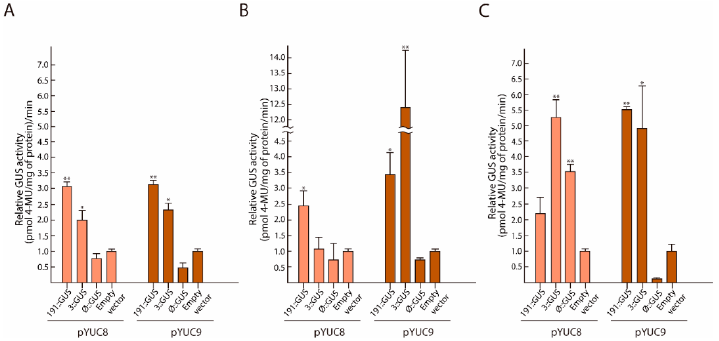
Figure A1. Genome browser screenshots showing the binding of MYC2 and MYC3 to the promoter regions of the eleven YUCCA genes. The figure shows the genomic regions around ( A ) YUC1 , At4g32540; ( B ) YUC2 , At4g13260; ( C ) YUC3 , At1g04610; ( D ) YUC4 , At5g11320; ( E ) YUC5 , At5g43890; ( F ) YUC6 , At5g25620; ( G ) YUC7 , At2g33230; ( H ) YUC8 , At4g28720; ( I ) YUC9 , At1g04180; ( J ) YUC10 , At1g48910; and ( K ) YUC11 , At1g48910. The corresponding YUCCA genes are marked in each panel. Possible binding sites, represented by an enrichment of sequence reads obtained from either MYC2 or MYC3 ChIP-seq assays, in the YUC promoters are highlighted by arrows. The data have been extracted from Zander et al. [40]. Array results are available under: http://neomorph.salk.edu/MYC2, last accessed: 8 September 2021.